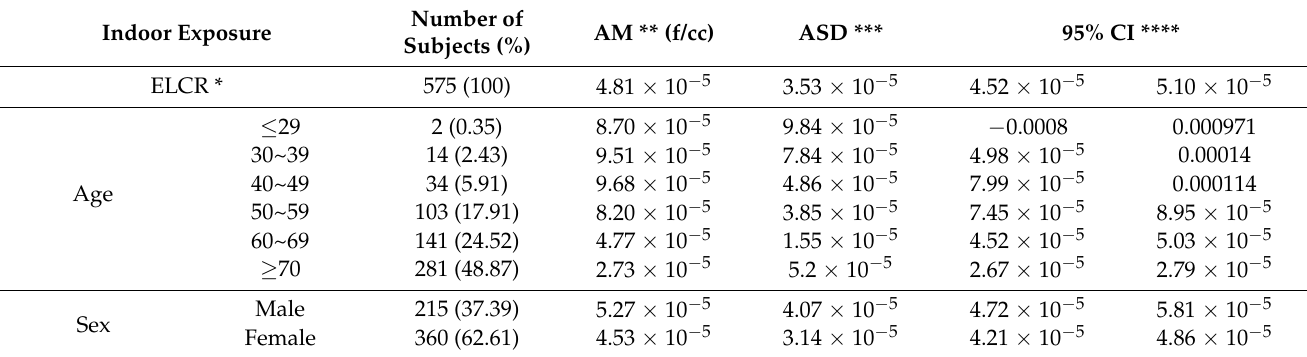
Table 5. ELCR by each asbestos-cement slate exposure